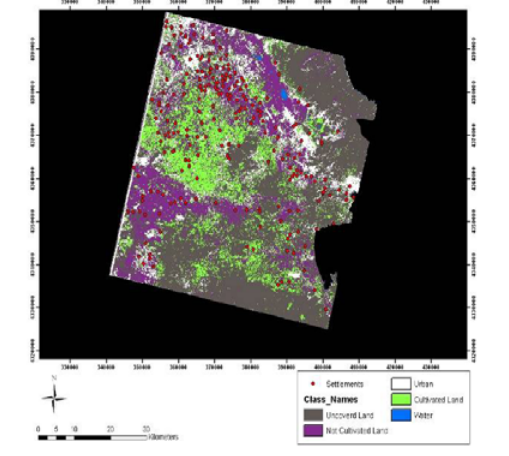
Figure 13. Results of the Land Classification of ASTER image through the use of Mahalanobis Distance (fuzzy)